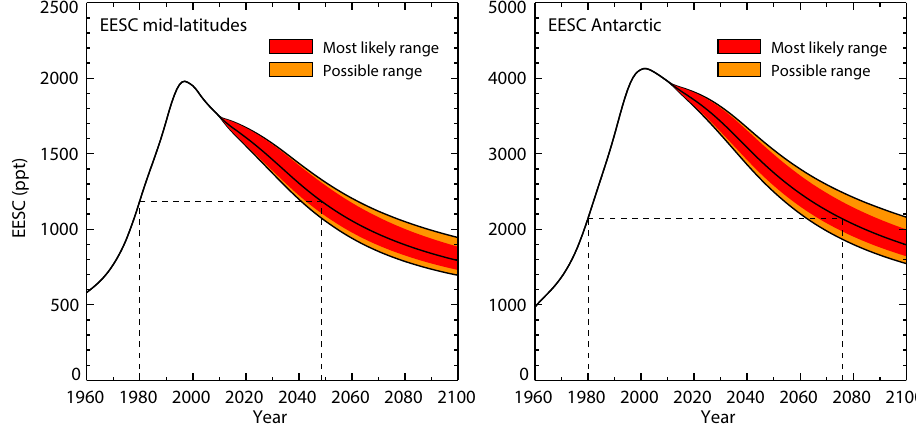
Fig. 4. EESC from 1960 to 2100 for midlatitude (left) and Antarctic (right) conditions using the lifetimes from SPARC (2013) and with uncertainties applied to the loss rates (inverse of lifetimes) of all species, except CH3Cl and the natural contribution of CH 3 Br. A correlation coefficient λ of 0.9 is used for the uncertainties in lifetimes among the ODSs mainly removed in the stratosphere and among those mainly removed in the troposphere. Shown are the median values and 95% confidence interval based on the possible (orange) and most likely (red) uncertainty ranges in lifetimes. The years EESC return to pre-1980 levels for the median EESC values is indicated with thin dashed lines.